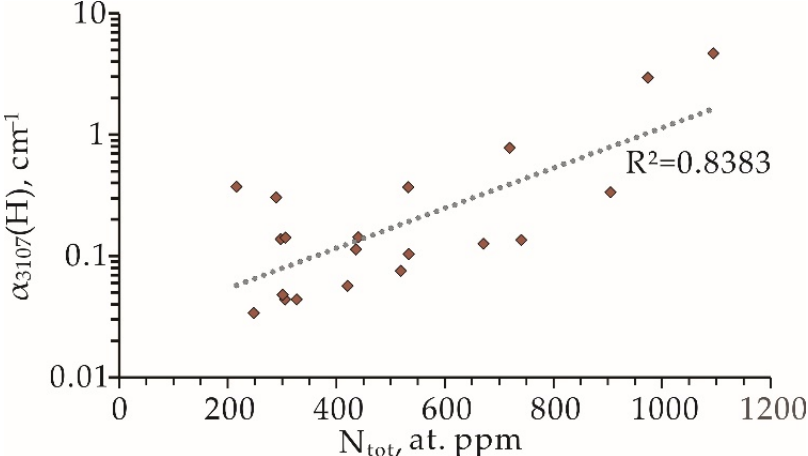
Figure 8. The integrated absorption of the α 3107 (H) vs. the concentration of total nitrogen content (N tot ) in the studied Hunan diamonds. The dotted line points to a possible correlation with R 2 = 0.8383.